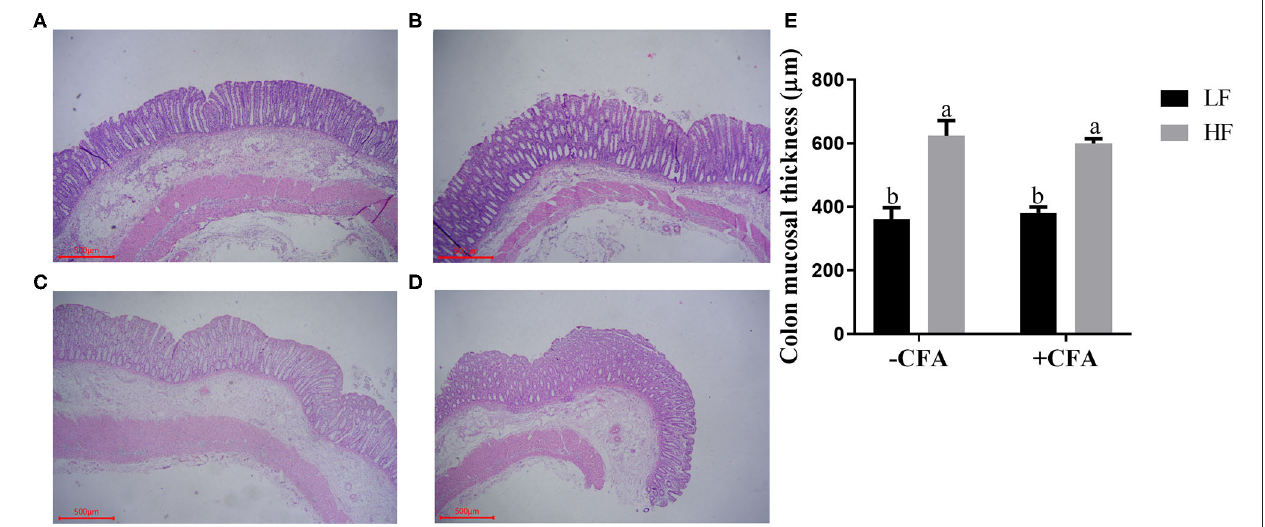
FIGURE 2 | Effect of dietary fiber on colonic mucosal thickness of piglets. (A) LF without CFA challenge; (B) HF without CFA challenge; (C) LF with CFA challenge; (D) HF with CFA challenge. Original magnification 200 × ; stained with hematoxylin and eosin staining. a,b Mean values within a row with different superscript letters were significantly different ( p < 0.05). (E) Histogram of colonic mucosal thickness data.